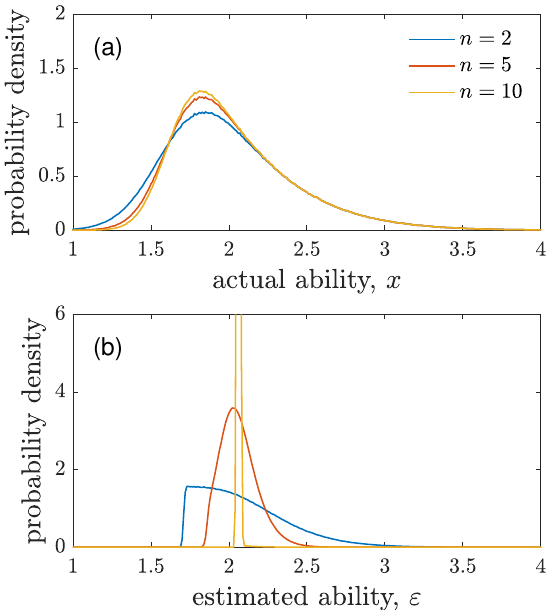
Figure 6: Distributions of actual (a) and estimated (b) ability for the prestige class under the dynamics of Case II, with w = 0.1. Here the standard error w < w there is no collapse of the prior. Data corresponds to n = 2; curves for larger values of n practically coincide.